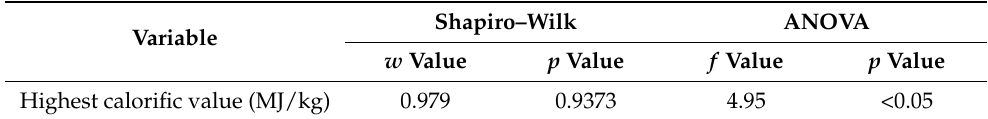
Table 6. Normality and analysis of variance tests of the highest heating value of pellets made with Agave durangensis fibers and Pinus spp. sawdust